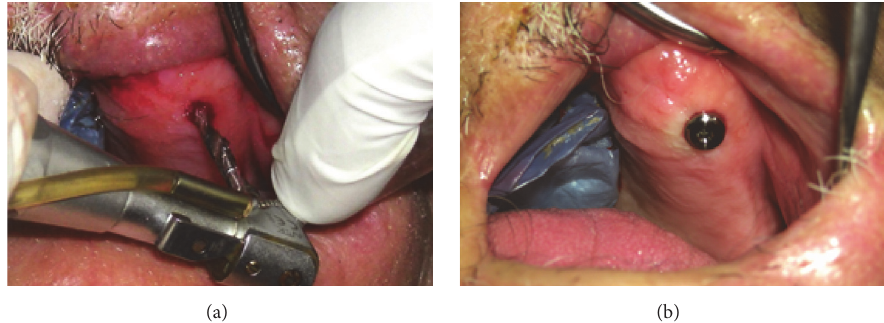
Figure 6: (a) Flapless implant placement. Note limited access of implant surgical hand-piece. (b) Healing abutment in place.